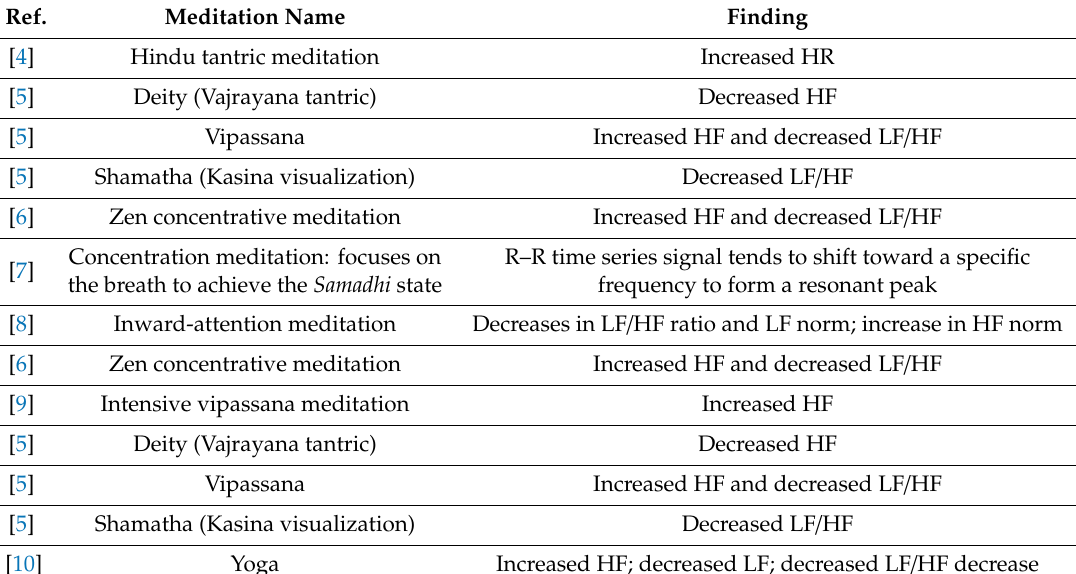
Table 1. Previous meditation studies involving autonomic nervous responses.